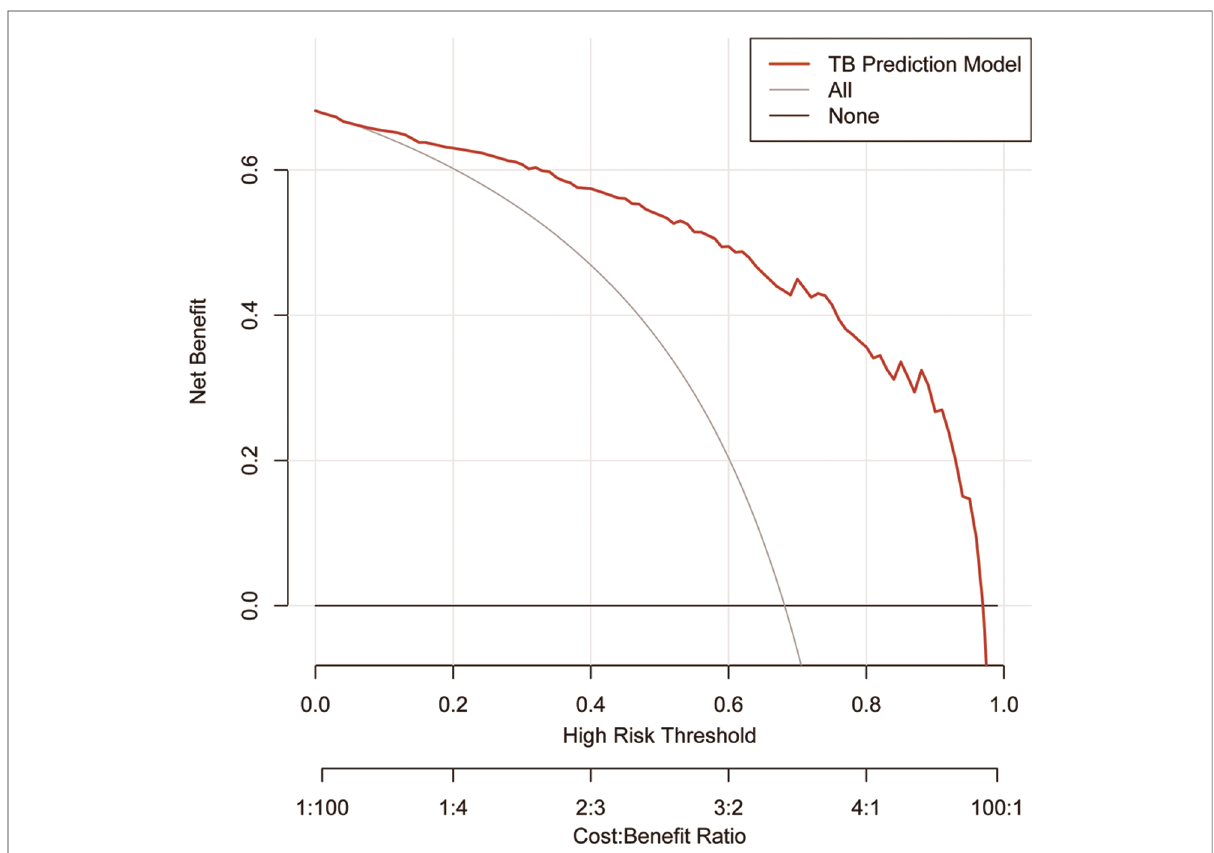
FIGURE 6 Decision curve analysis for the TS prediction model in the training set. The red line represents the TS predictive model. The thin solid line represents the assumption that all patients are considered to be diagnosed with TS. The thick solid line represents the assumption that no patients suffer from TS. The decision curve analysis indicated that using this TS prediction model could gain net bene fi t when the threshold probabilities >4%. TS, tuberculous